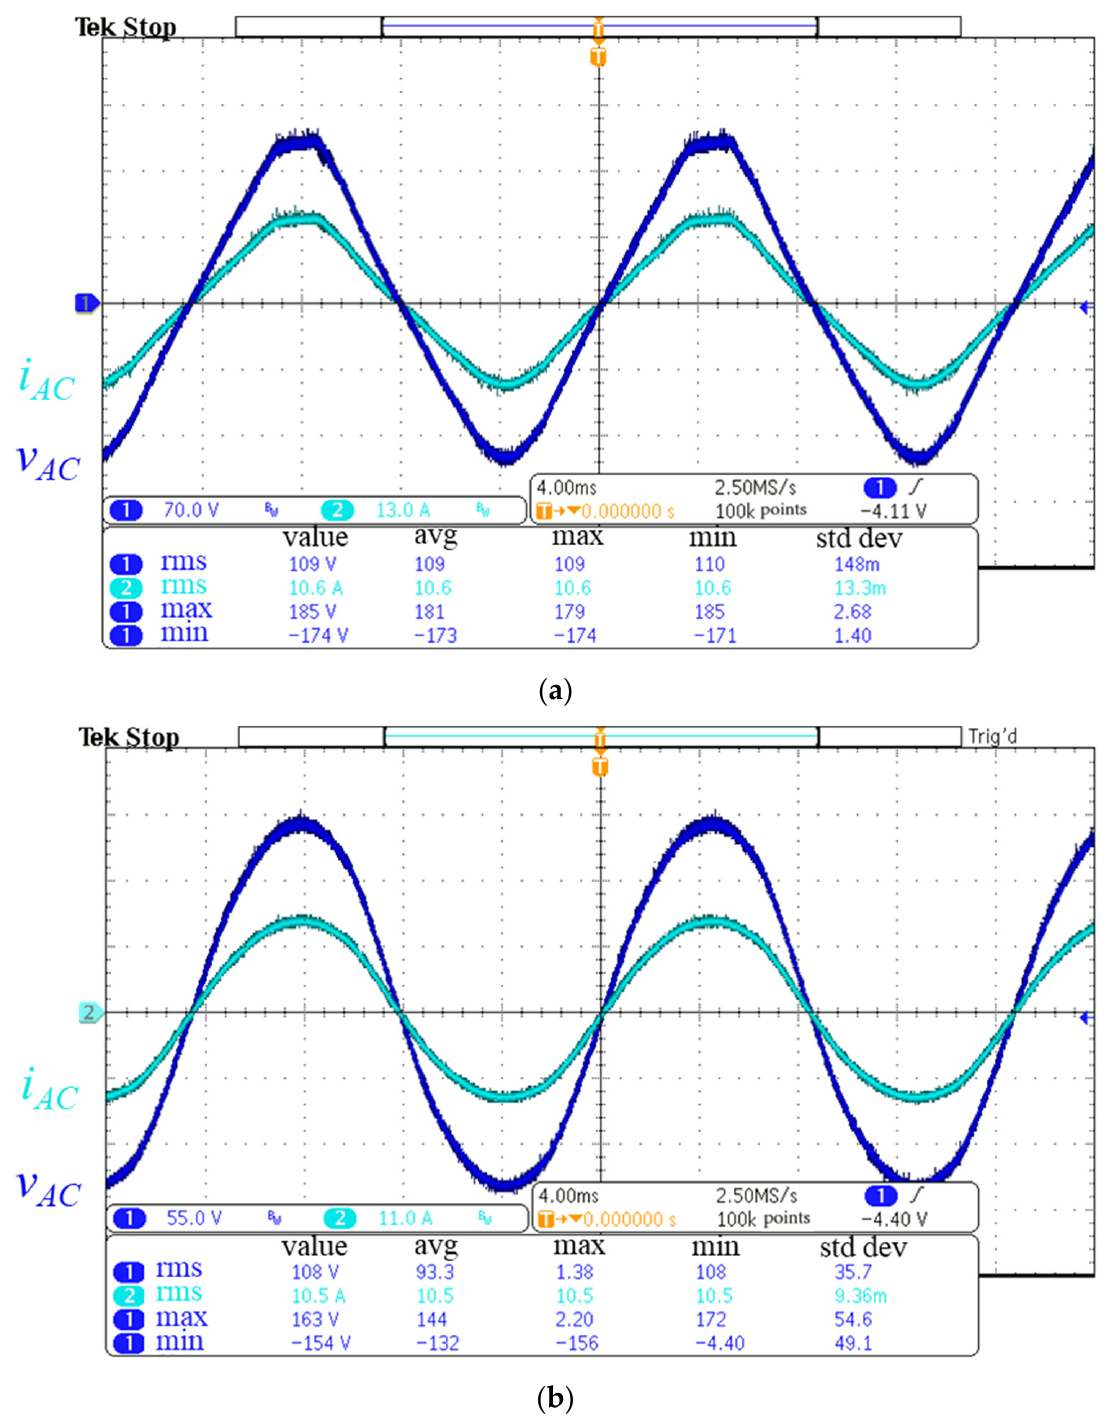
Figure 20. The measured results (1 kW) of the voltage and current output waveforms when using ( a ) the traditional SPWM control and ( b ) modified SPWM control.